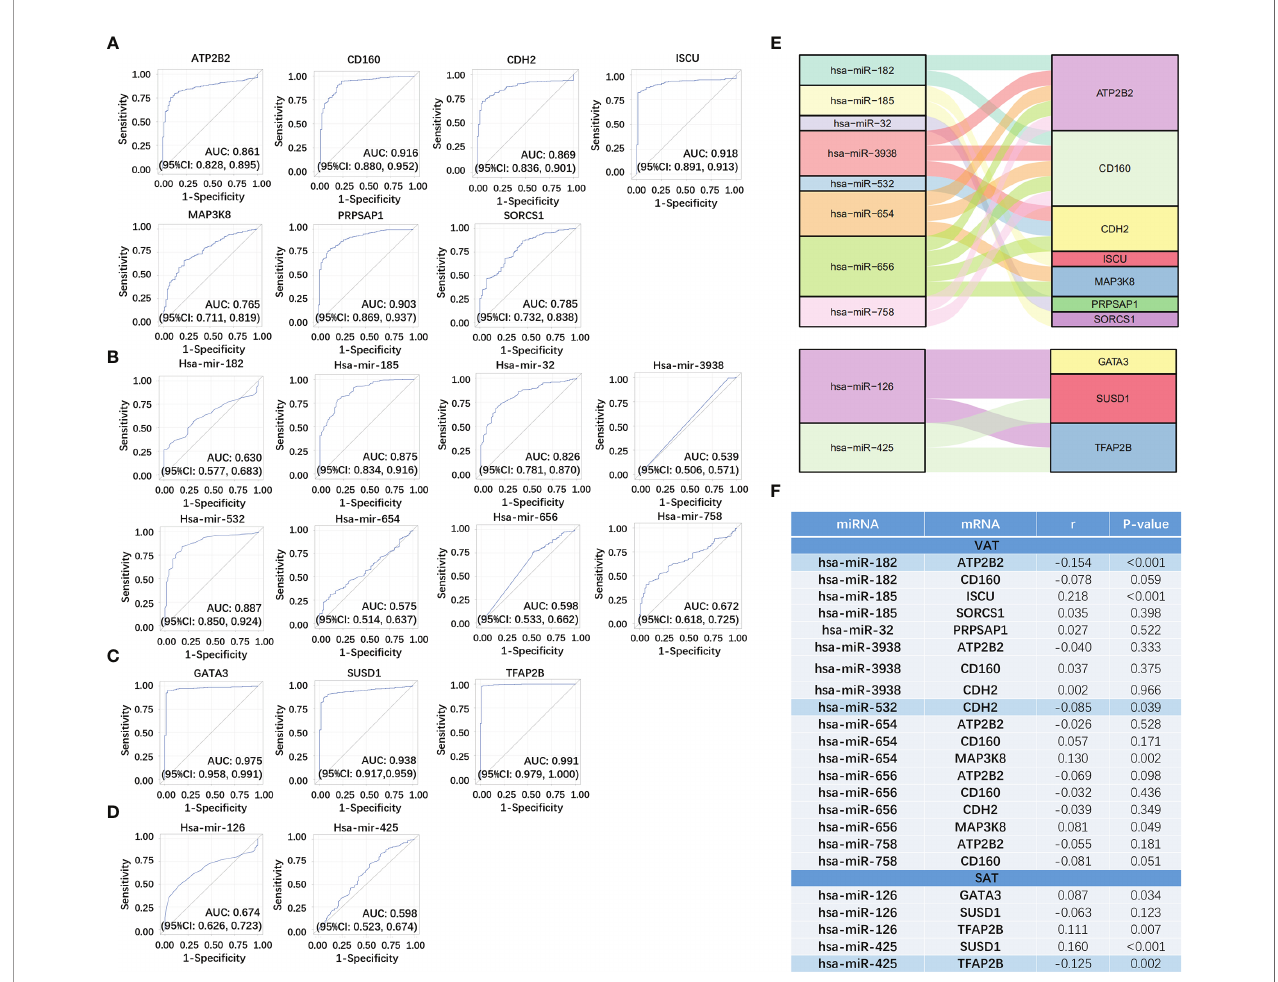
FIGURE 6 | Veri fi cation of miRNA-mRNA networks of obesity-related ccRCC using TCGA dataset. For VAT, 7 mRNA (A) and 8 paired miRNAs (B) with statistically signi fi cant ORs were retrained. For SAT, 3 mRNA (C) and 2 paired miRNAs (D) with statistically signi fi cant ORs were retrained. miRNA-mRNA networks of obesity- related ccRCC were visualized using Sankey Diagram (E) . Spearman correlation analyses (F) found that 3 miRNA-mRNA pairs showed inverse relationship with statistically signi fi cant correlation coef fi cients, including hsa-miR-182&ATP2B2 in VAT, hsa-miR-532&CDH2 in VAT, and hsa-miR-425&TFAP2B in